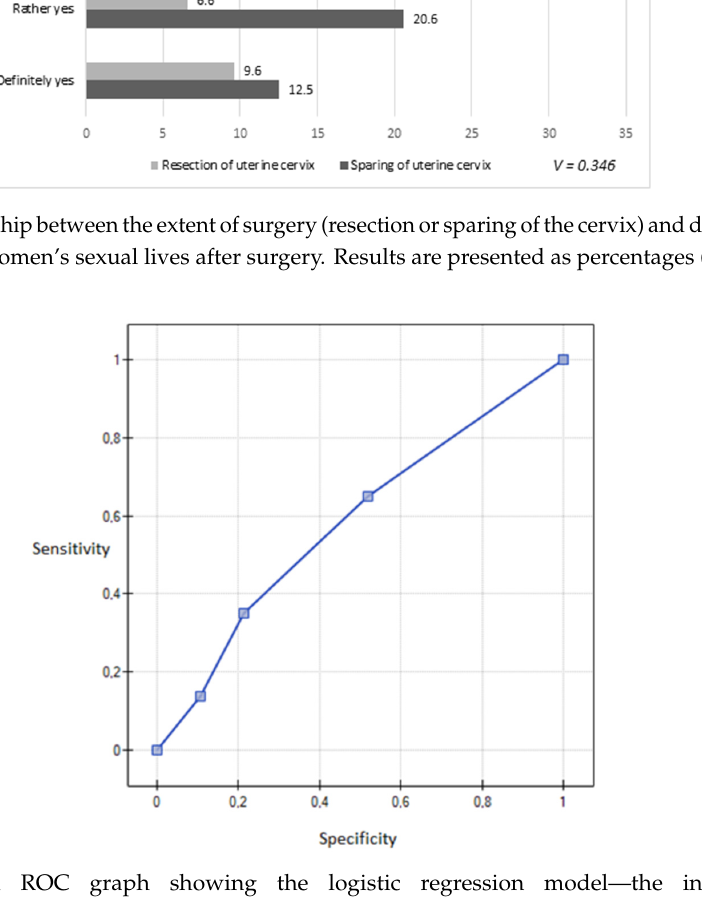
Figure 5. An ROC graph showing the logistic regression model—the influence of salpingo- oophorectomy on changes in sexual activity .